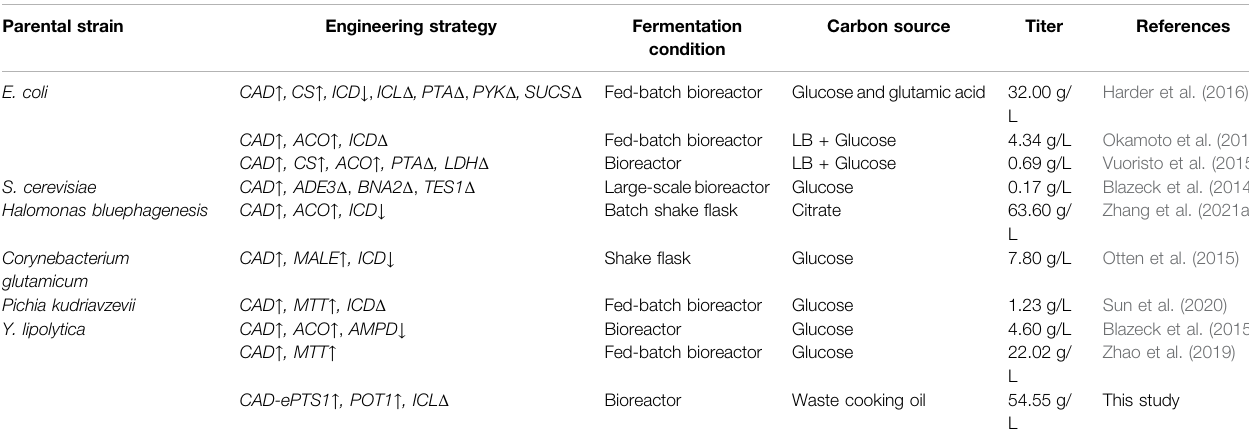
TABLE 1 | Representative examples of IA production in engineered microbial hosts. Parental